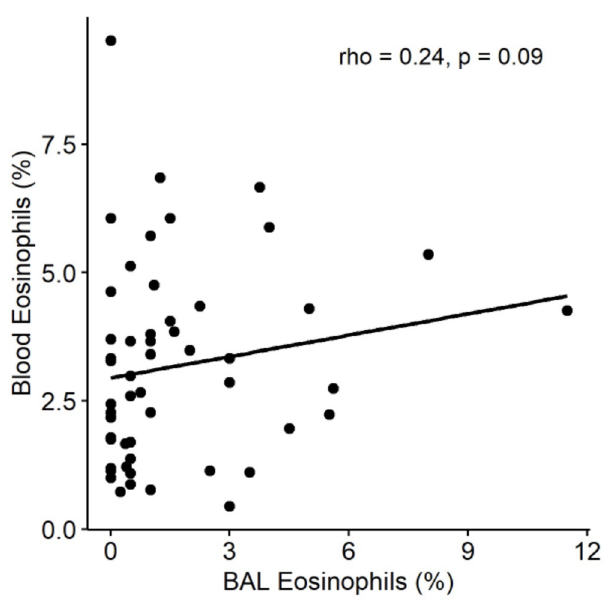
Figure 3. Relationship between BAL and peripheral blood eosinophil counts at baseline in the DISARM trial. There was no correlation between eosinophil proportions in the two compartments (Spearman’s rho 0.24, p = 0.09). Abbreviations: BAL, bronchoalveolar lavage.